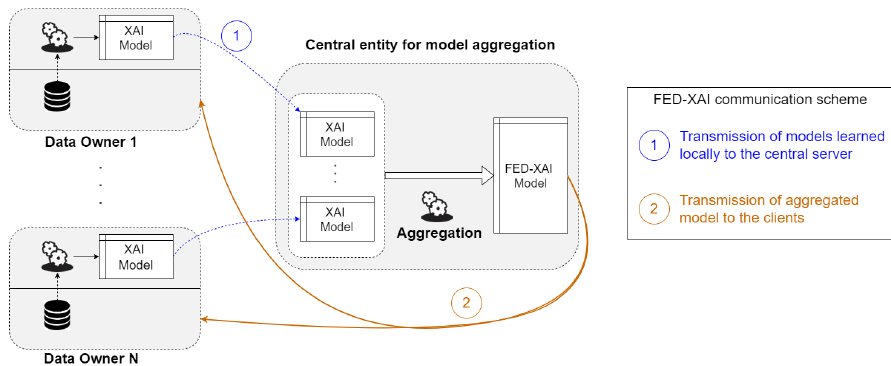
Figure 1. Illustration of federated learning of XAI